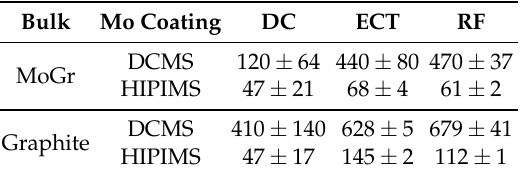
Table 7. Resistivity (in n Ω m) measured with the DC, ECT and RF techniques for DCMS and HIPIMS Mo coatings on MoGr or graphite substrates.